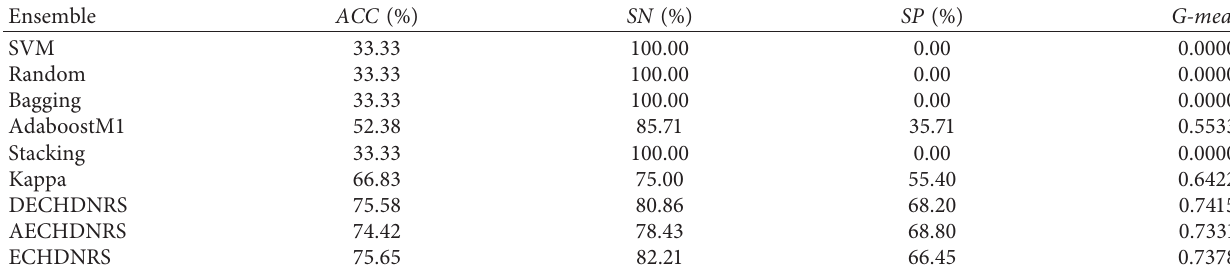
Table 7: Classification results on Arabidopsis -TEV